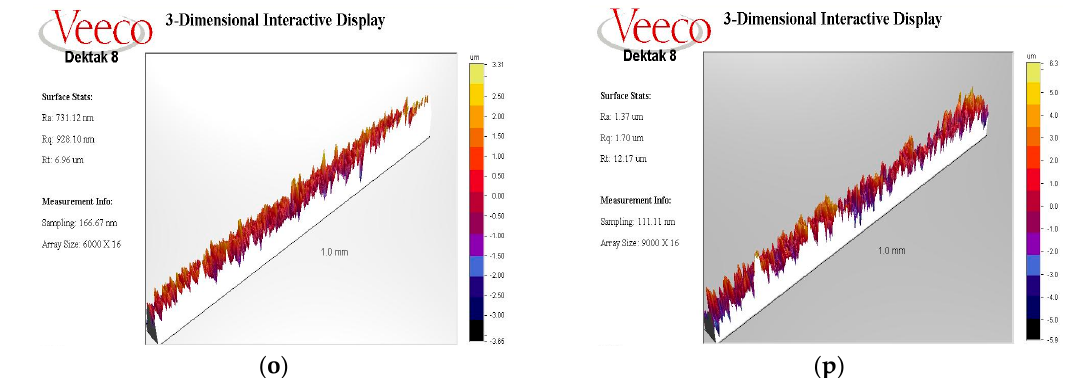
Figure 10. Profilometry graphic sample of the Ti-Cur group ( a ) Ra score baseline 724.45 nm; ( b ) after intervention 1.57 μ m; ( c ) The US-PEEK group Ra score baseline 5.63 μ m; ( d ) after intervention 1.76 μ m, In the baseline measurement, a large debris (30.3 μ m) in a relatively small area was observed to increase the mean roughness (Ra 5.63 μ m). Although an increase in roughness was observed in the graph after intervention, the average roughness value decreased (Ra 1.76 μ m); ( e ) the ErL-VSP group Ra score baseline 1.54 μ m; ( f ) after intervention 2.61 μ m, Although the yellow color scale in the initial measurement graph of this sample turned into a dark color scale due to the reduction of the debris layer in the thread, debris at one point peaked in the graph; ( g ) the ErL-SP group Ra scores baseline 1.82 μ m; ( h ) after intervention 1.44 μ m; ( i ) The ErL-LP group Ra score baseline 3.30 μ m; ( j ) after intervention 1.22 μ m, in all implant samples from ErL-SP and ErL-LP groups, the roughness graph of after debridement measurement shows a closer look to the image of control implants than the initial measurement; ( k ) the ErCrL-1 group Ra score baseline 1.39 μ m; ( l ) after intervention 1.30 μ m; ( m ) the ErCrL-2 group Ra score baseline 868.14 nm; ( n ) after intervention 1.64 μ m, in ErCrL-2 group implants, a homogeneous peak-to-valley distribution cannot be observed in the roughness graph after debridement; ( o ) the control group Ra scores 731.12 nm; ( p ) 1.37 μ m.